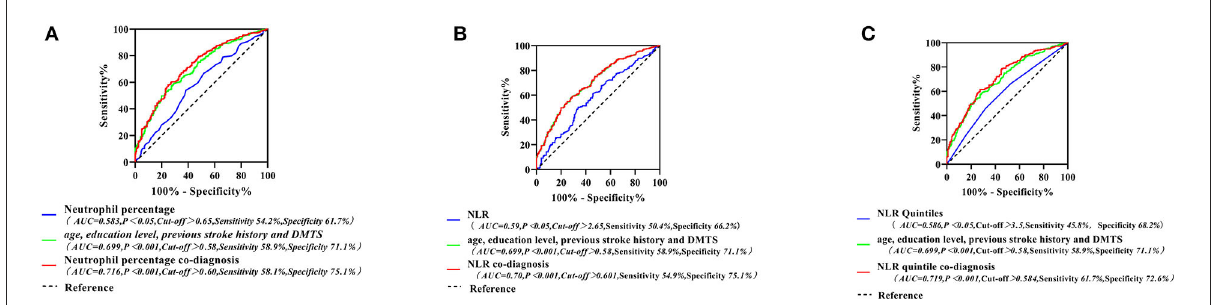
FIGURE5 Neutrophil percentage and its combination with other indicators for the ROC curve of PSCI (A) ; ROC curves of NLR and its combined other indicators for PSCI (B) ; ROC curves for the NLR quintile and its combination with other indicators for the PSCI (C) . PSCI, post-stroke cognitive impairment; NLR, neutrophil/lymphocyte ratio; ROC, receiver operating characteristic